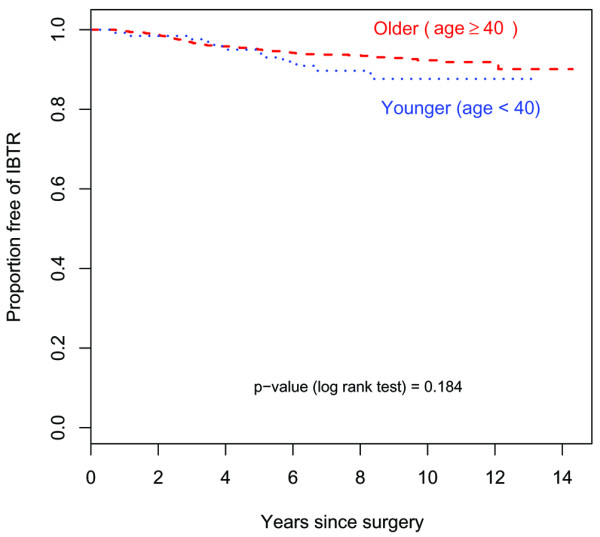
Kaplan–Meier estimate of IBTR stratified by age under or over 40 years. IBTR, ipsilateral breast tumour recurrence.